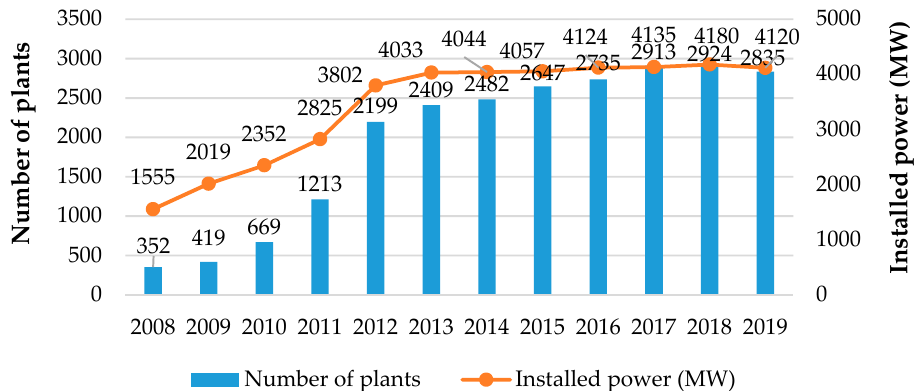
Figure 1. Number of bioenergy plants and amount of installed power in Italy from 2008 to 2019.